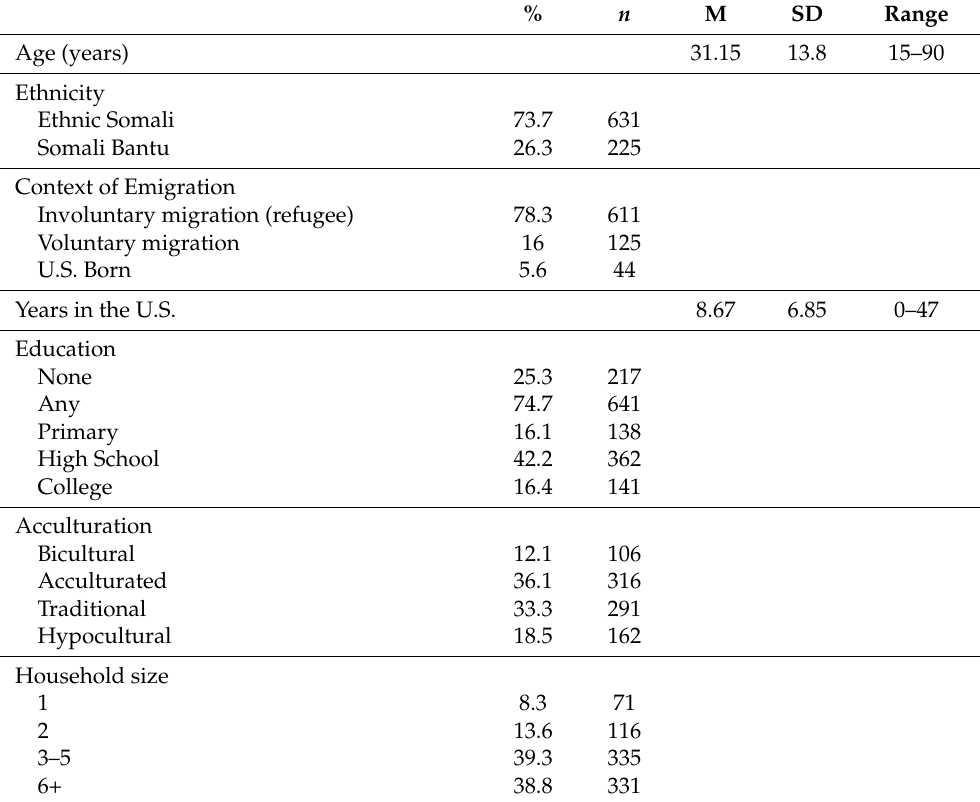
Table 1. Participant